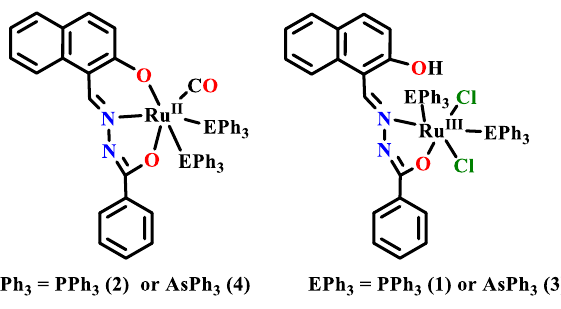
Figure 36. Ruthenium complexes of naphthylhydrazone with benzamide side chain reported by Eswaran Jayanthi’s group.